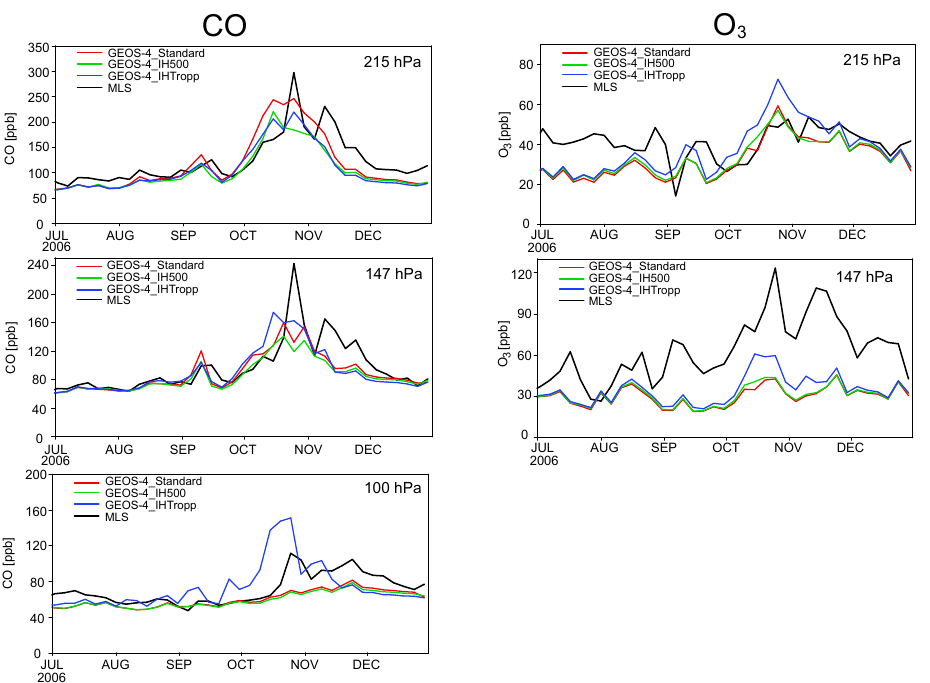
Fig. 10. MLS observed (black line) and GEOS-Chem simulated (driven by GEOS-4 meteorological data) upper tropospheric CO and O 3 concentrations over the WCI (see Fig. 1) from July to December 2006. Model results from sensitivity simulations where biomass burning emissions are injected uniformly up to 500hPa (GEOS-4 IH500) and the tropopause (GEOS-4 IHTropp) as well as the standard simulation (GEOS-4 Standard) are shown. See text for detailed descriptions of the